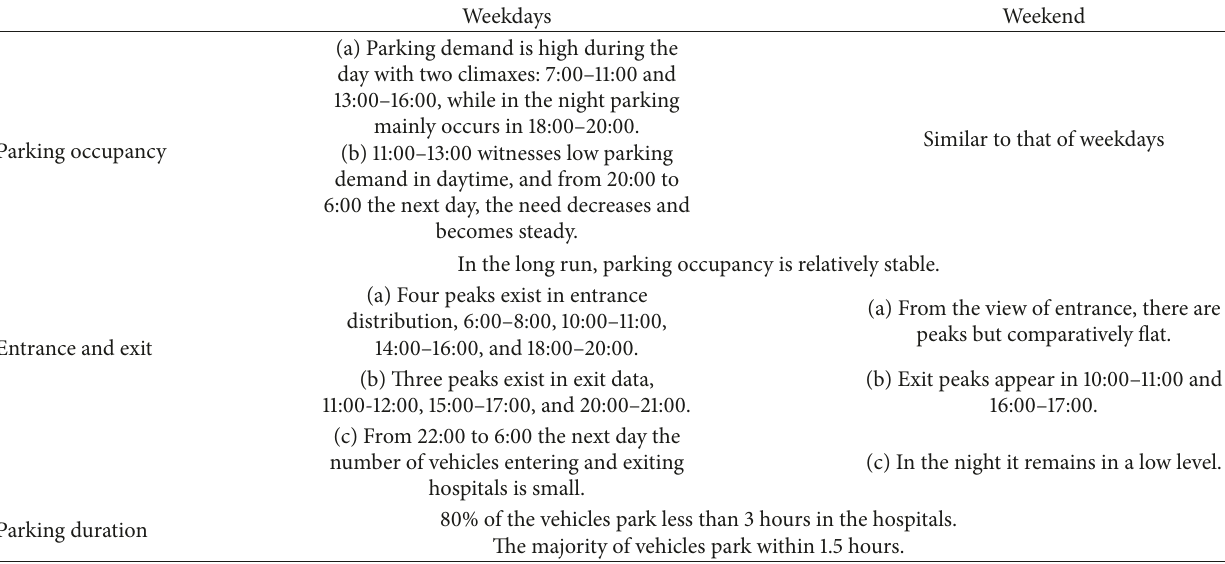
Table 1: Time-varied characteristics of parking